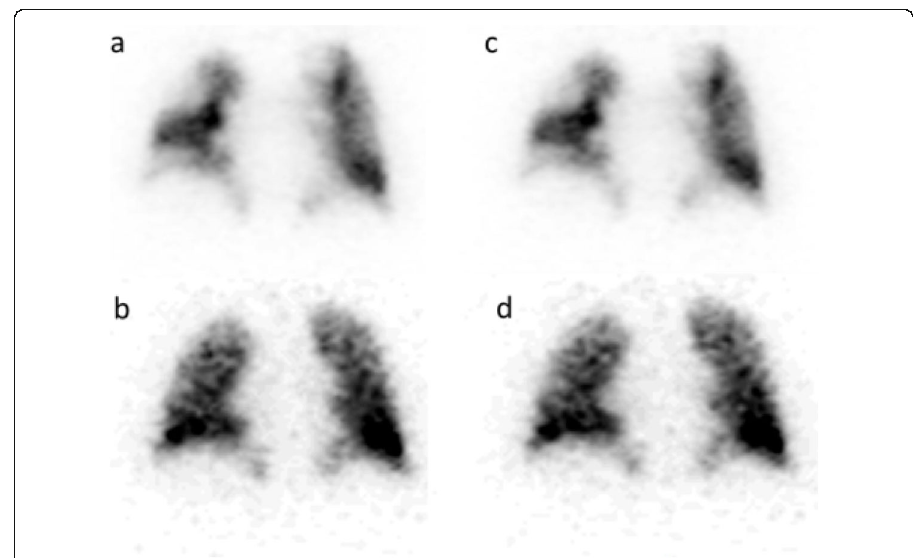
ventilation) images on coronal views. Images were rated as 4 for the 2 modes